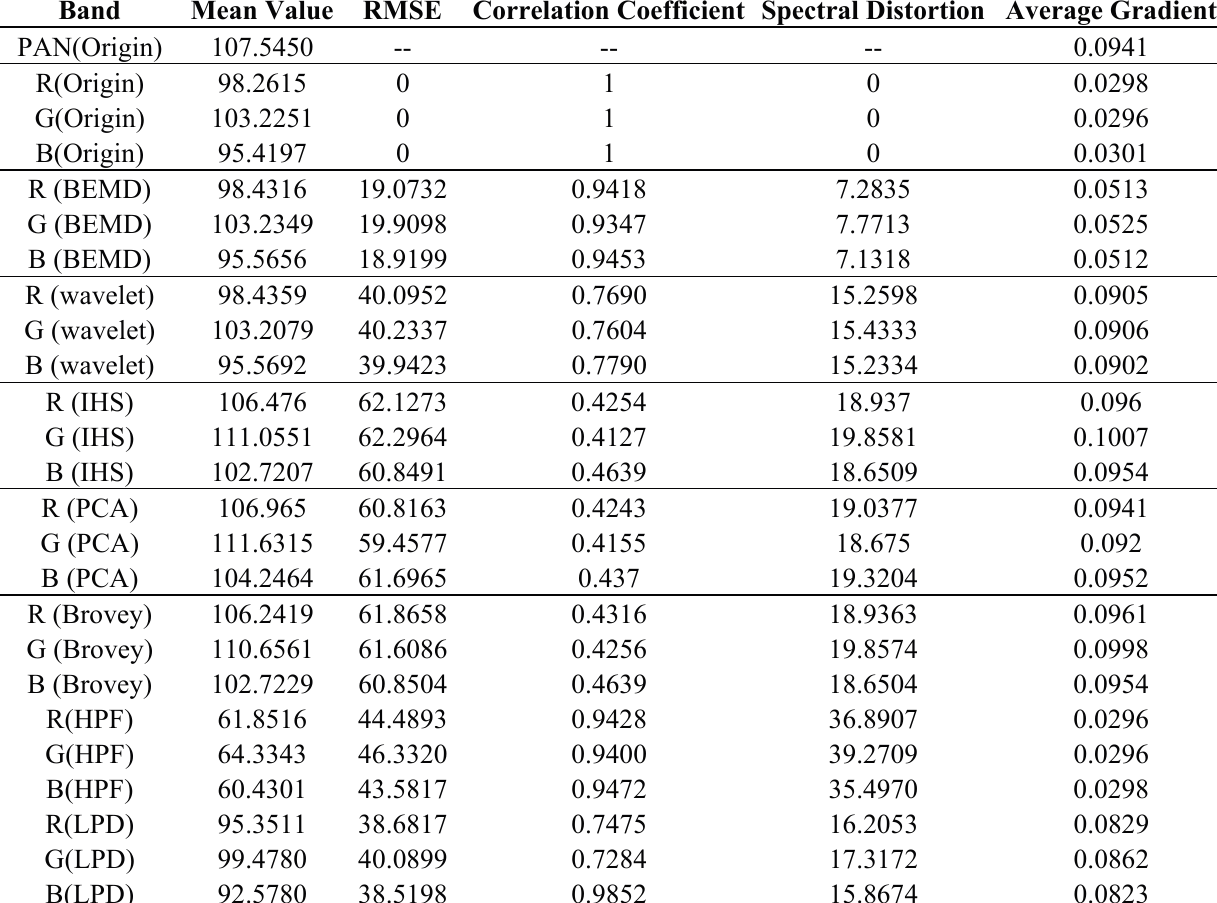
Table 1. Quantitative analysis of the BEMD, wavelet, IHS, PCA, and Brovey image fusion